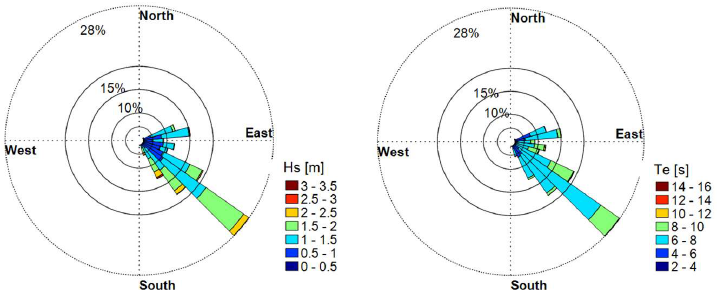
Figure 3. Total probability distribution of significant wave height H s wave mean period T e and wave mean direction versus mean wave direction MD ir in Kilifi. The frequencies of occurrence of sea states are given in percentage.